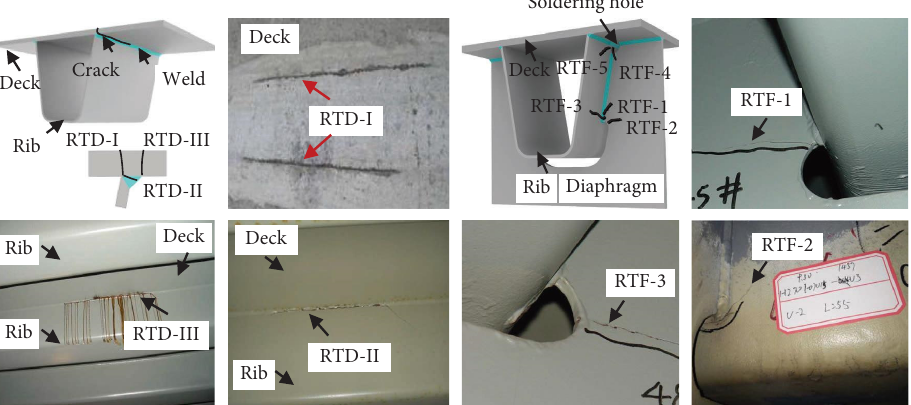
Figure 1: Fatigue cracks in OSDs.